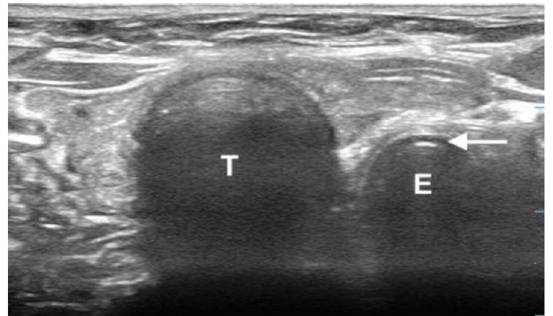
Fig. 2 Sonographic image of esophageal intubation